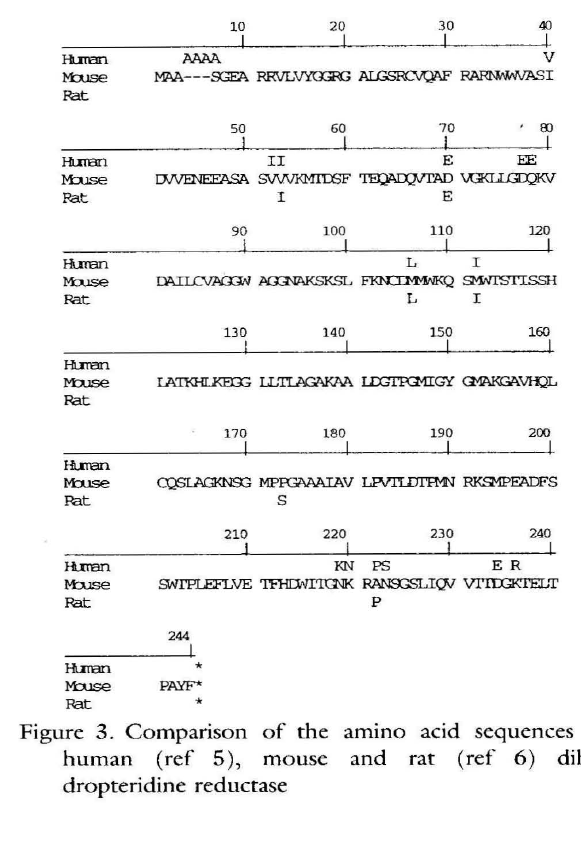
Table I. Kinetic parameters of mouse and human dihydropteridine reductase from cDNA expressed in E coli and